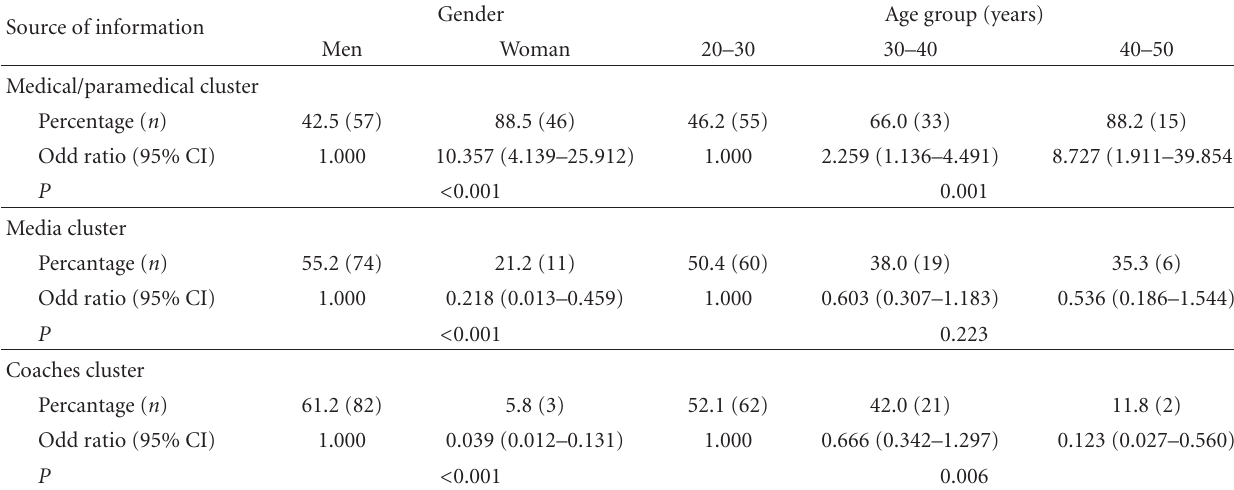
Table 5: Source of supplement information by gender and age group ( n =